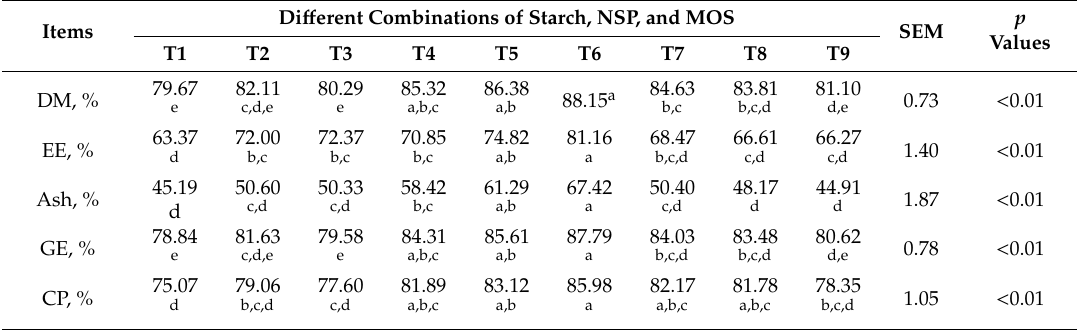
Table 7. E ff ects of di ff erent combinations of starch, NSP, and MOS on the nutrient apparent digestibility of weaned